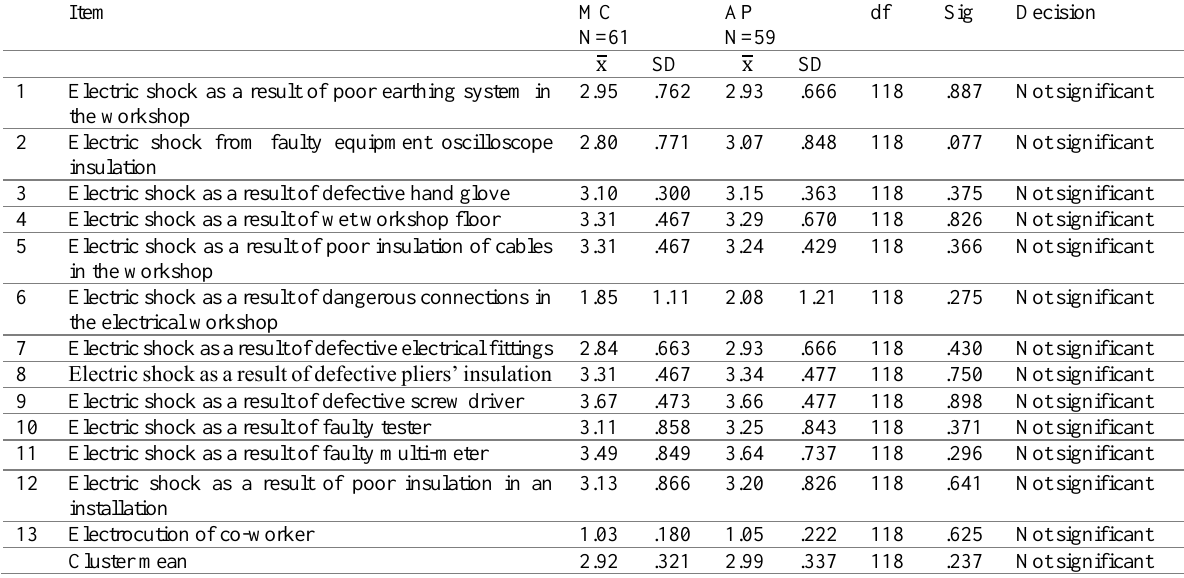
Table 8: The t-test Analysis Comparing Response from the Master Craftsmen and the Apprentice on the Rate of Electrical Related Accidents in the Electrical/Electronics